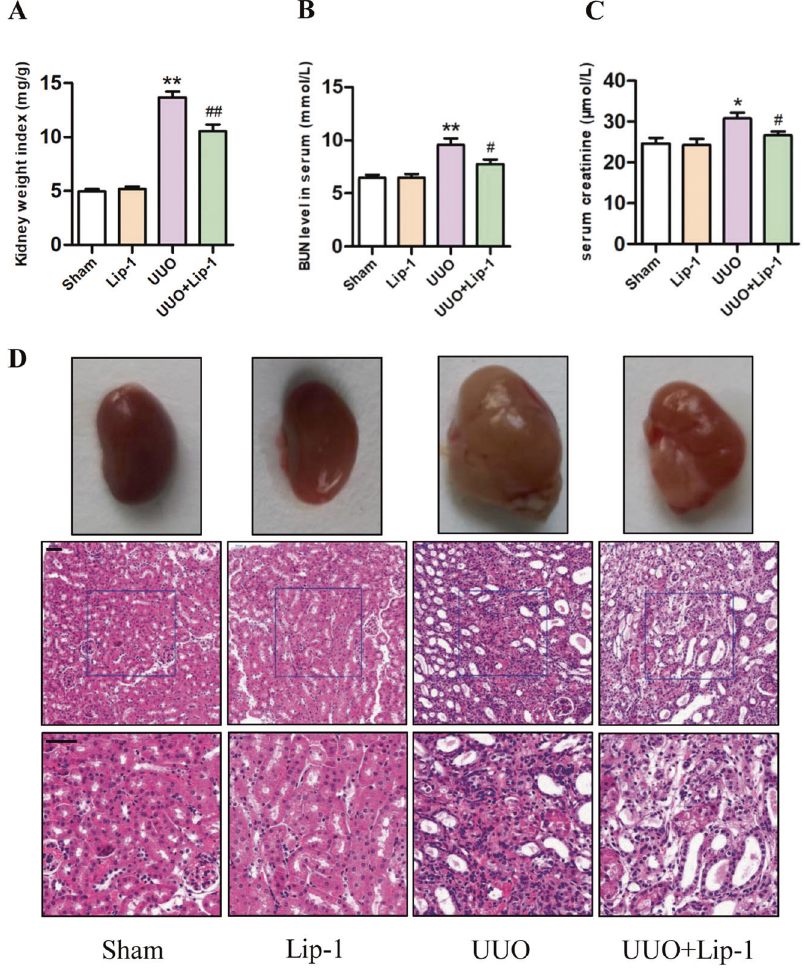
Fig. 2 Effects of Liproxstatin-1 on kidney weight index, renal function, and histological alteration in the UUO model. A Ratio of obstructed kidney/body weight in mice ( n = 6, ** P < 0.01 vs Sham group; ## P < 0.01 vs UUO group). B , C Measurement of the levels of BUN and Scr in serum of mice ( n = 5, * P < 0.05, ** P < 0.01 vs Sham group; # P < 0.05 vs UUO group). D Morphology of the kidney samples and representative micrographs of H&E staining (bar = 50 μ m). The data are presented as the mean ±